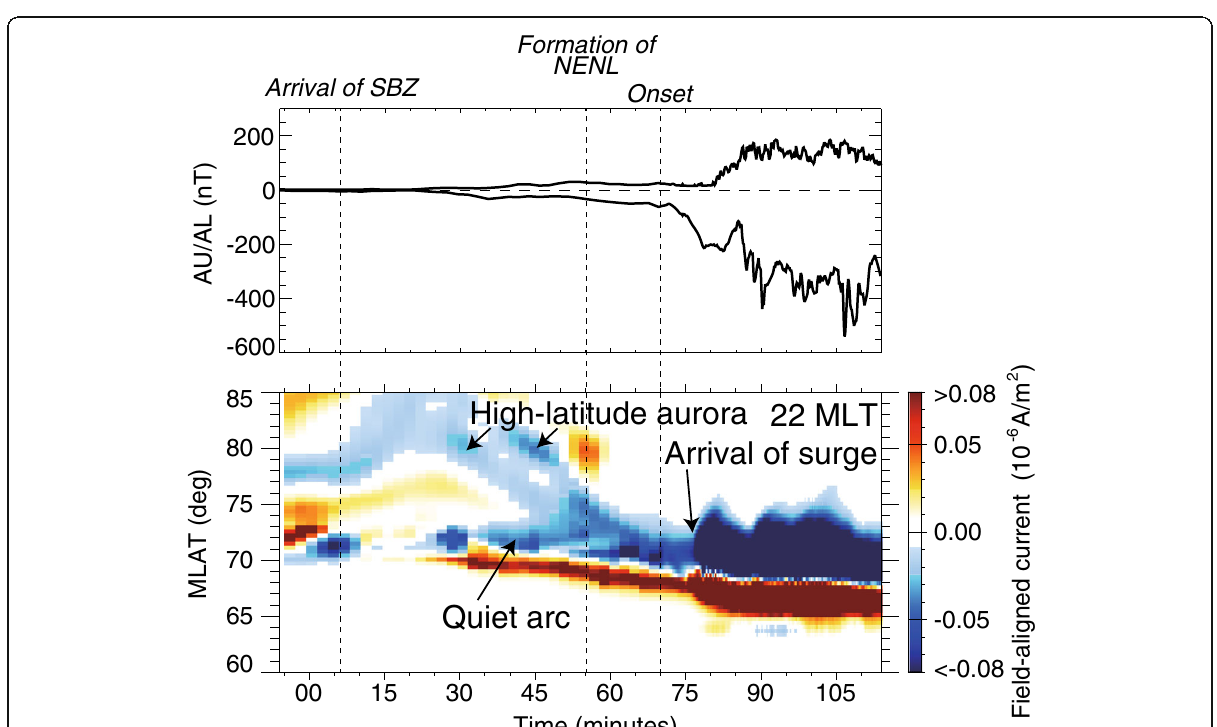
Fig. 3 (Top) AU and A L indices and (bottom) field-aligned currents (negative upward) as a function of MLAT and time. (Adapted from Ebihara and Tanaka